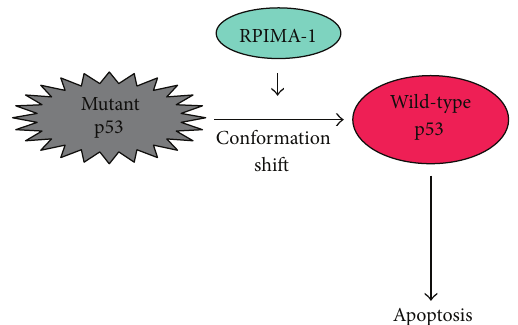
Figure 3: PRIMA-1 reactivates mutant p53. Small chemical com- pound termed PRIMA-1 has an ability to reactivate mutant p53 through the conformation